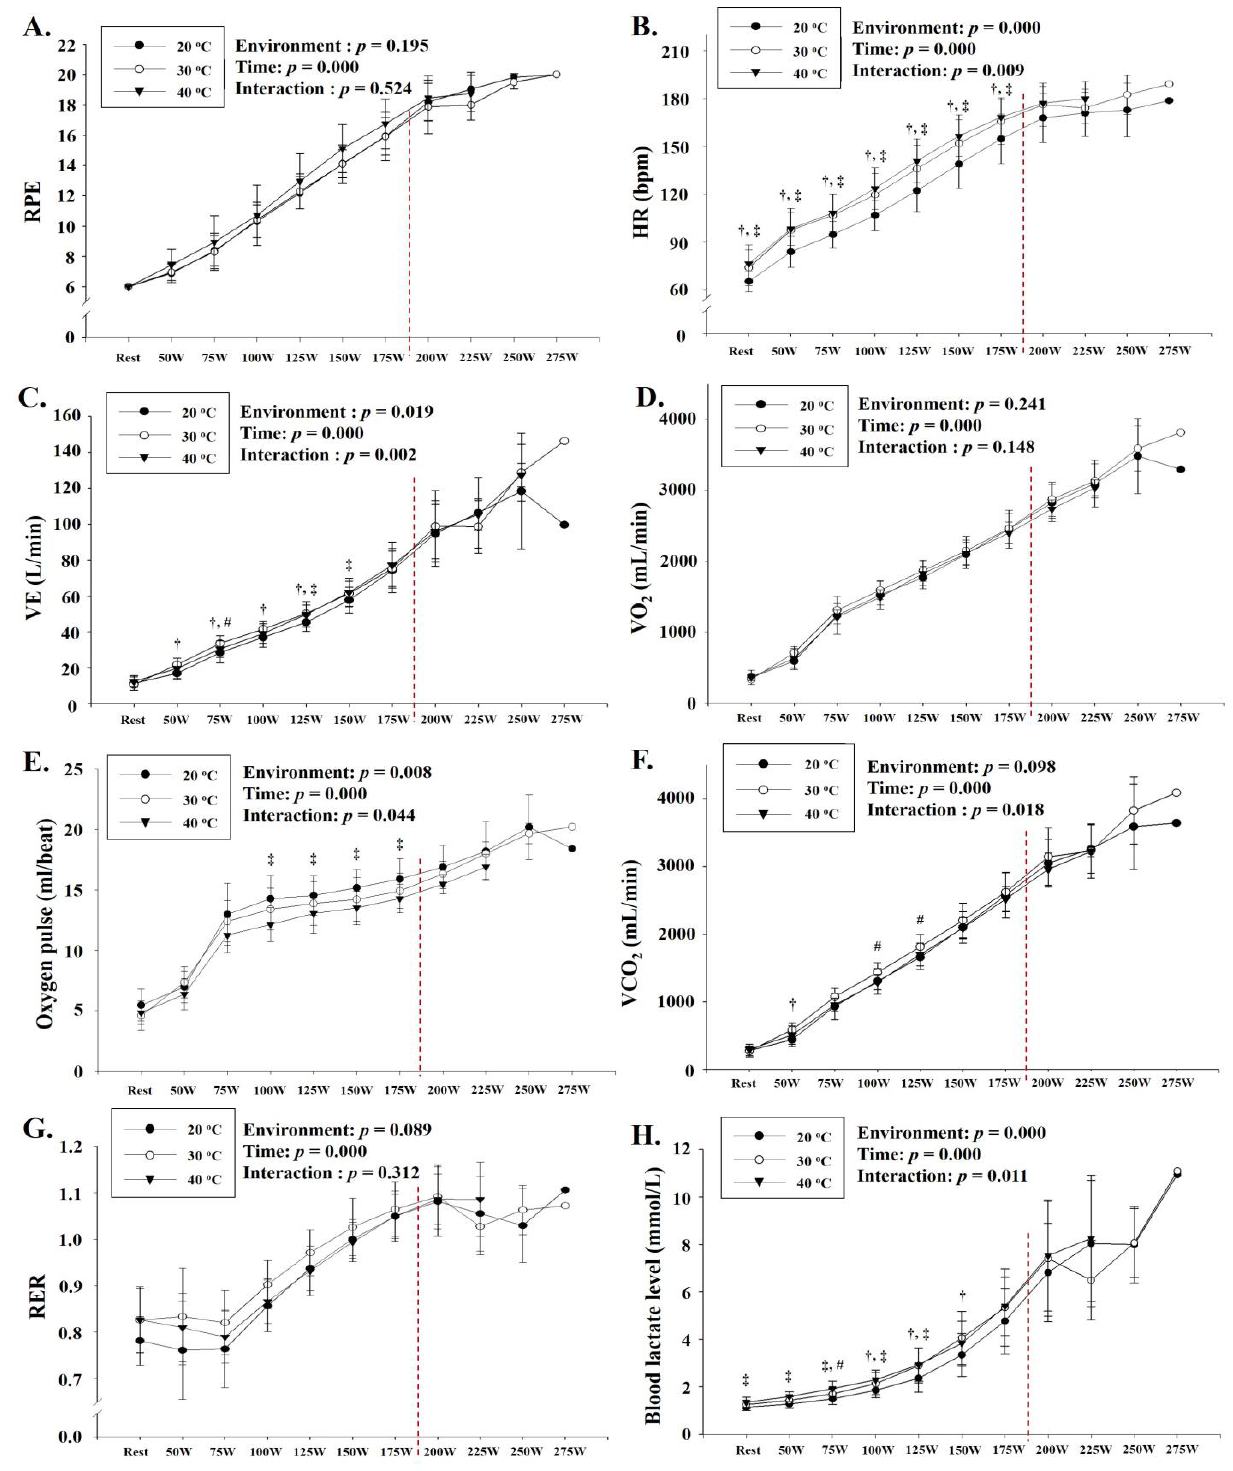
Figure 4. Changes in cardiorespiratory function parameters at rest and during GXT (mean ± standard deviation): ( A ) change in RPE, ( B ) change in HR, ( C ) change in VE, ( D ) change in VO 2 , ( E ) change in oxygen pulse, ( F ) change in VCO 2 , ( G ) change in RER, and ( H ) change in blood lactate level are shown. GXT: graded exercise test; RPE: rating of perceived exertion; HR: heart rate; VE: minute ventilation; VO 2 : oxygen uptake; VCO 2 : carbon dioxide excretion; RER: respiratory exchange ratio. †: significant difference between 20 °C and 30 °C ; ‡: significant difference between 20 °C and 40 °C; #: significant difference between 30 °C and 40 °C.